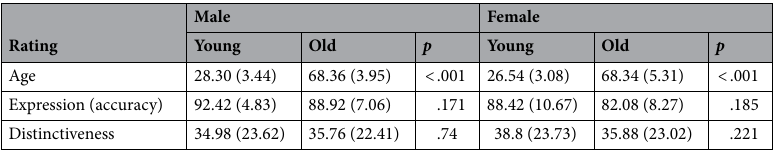
Table 1. Mean ratings (SD) for young and older selected